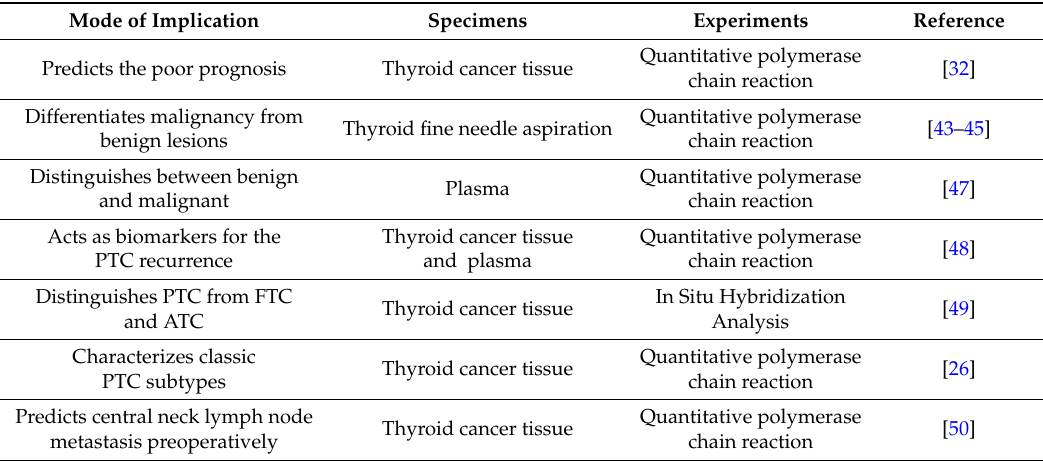
Table 2. Clinical applications of highly expressed miR-146b in